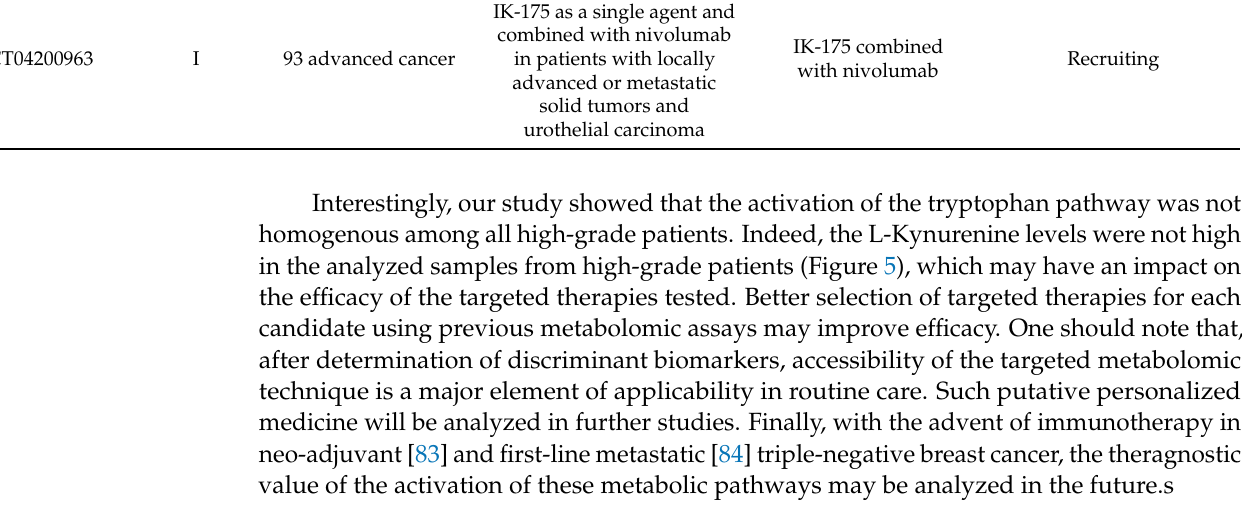
Figure S2: Untargeted metabolomic statistical analyses of SBR grades in the training set ( n = 51) and the validation set (n = 49) using the top 12 metabolites; Figure S3: Metabolomic fingerprint- ing allowed accurate discrimination of SBR grades using the top 25 most important metabolites; Figure S4: Untargeted metabolomic statistical analyses of SBR grades of the training set and validation set using the top 25 metabolites; Figure S5: Schematic representation of metabolic pathway changes; Figure S6: Schematic representation of metabolic pathway changes; Figure S7: Heatmap represen- tation of relative concentrations of tryptophan catabolites of the training set and the validation set; Table S1: Significant pathways of the SBR grade